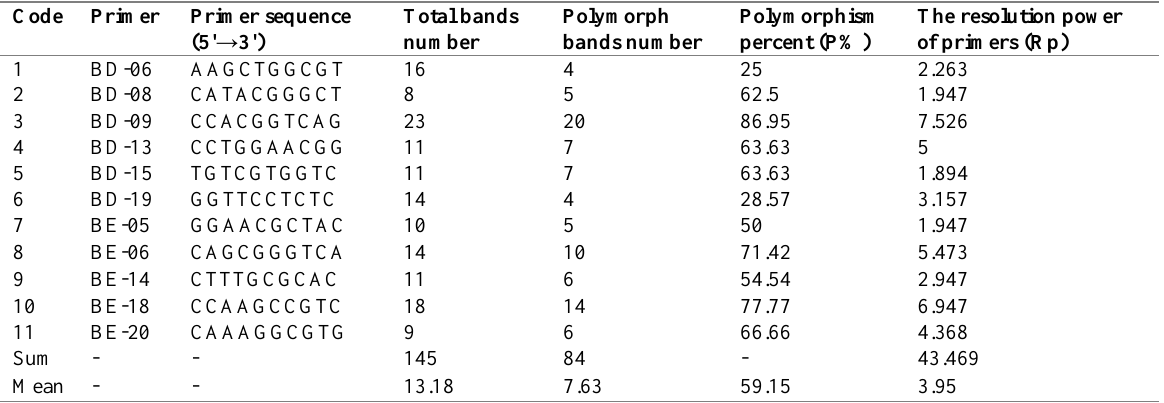
Fig. 1. The measured morphological features were taken from Hodalova et al. (2008). Table 3. Information on used random primers and their obtained bands .